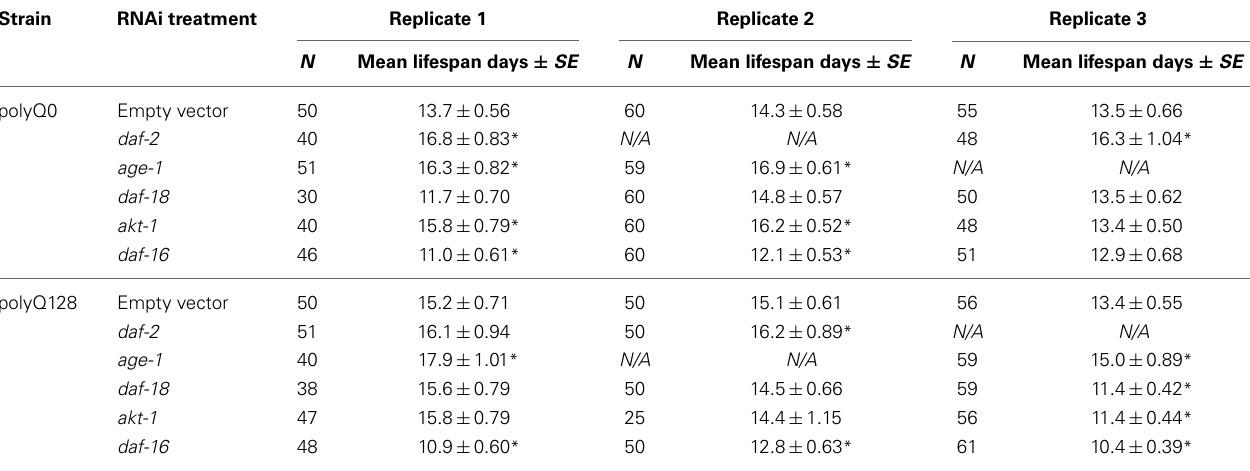
Table 2 | Effects of RNAi treatment targeting insulin signaling on polyQ0 and polyQ128 animals’ mean lifespan. Strain RNAi